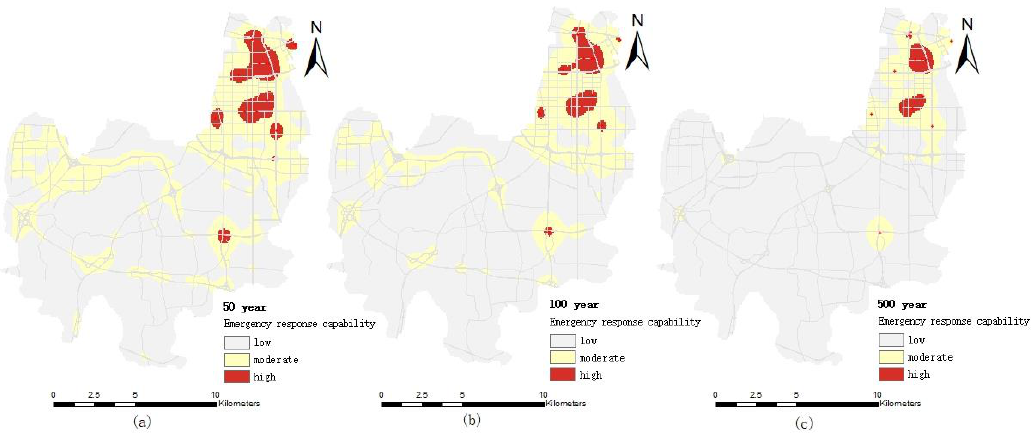
Figure 6. Distribution map of emergency response capacity of medical institutions with different r pluvial flooding scenarios: ( a ) the 50-year pluvial flooding scenario; ( b ) the 100-year pluvial flooding scenario; ( c ) the 500-year pluvial flooding scenario.